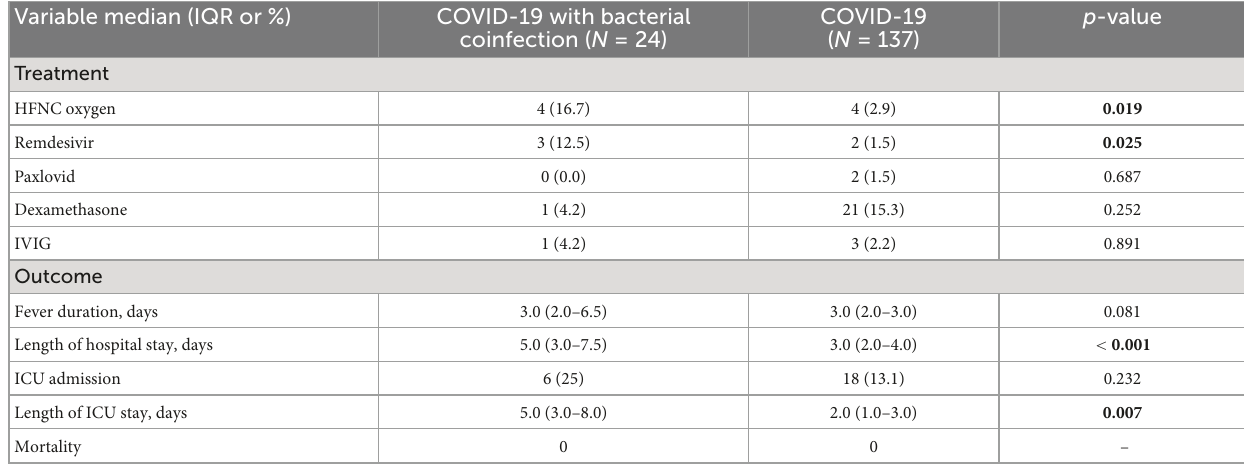
TABLE 3 Comparison of treatment and outcomes of both